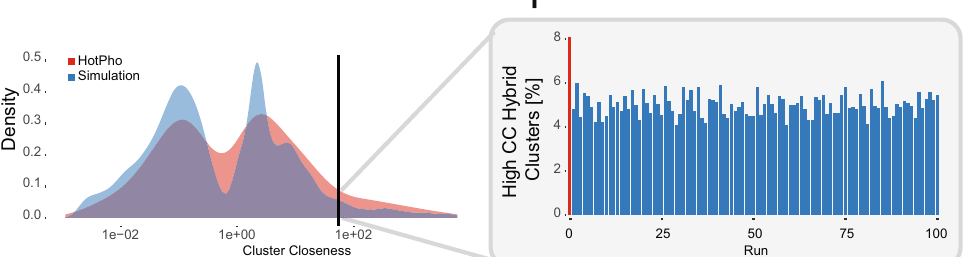
Fig. 1 HotPho work fl ow and performance benchmarks. a HotPho takes user-provided lists of mutations and phosphosites as inputs, map them onto PDB protein structures, calculates each of the pairwise distances, conducts clustering, and reports clusters with prioritized mutations and phosphosites. b Comparison of HotPho results measured using phosphosite and MC3 cancer mutation data vs. simulated data of randomly distributed phosphosites. The left panel indicates the density of cluster closeness (CC) scores for all hybrid clusters in the HotPho run and the simulated runs, where the vertical line indicates the top 5% score threshold. The right panel shows the bar plot comparing the number of hybrid clusters passing the same 5% threshold in the HotPho and simulated